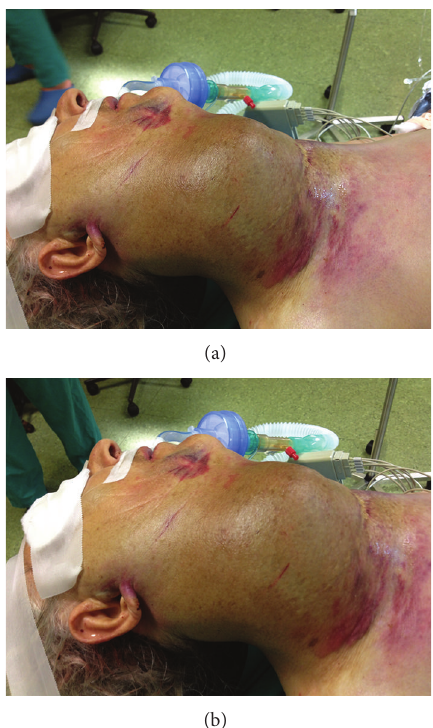
Figure 1: Patient intubated endotracheally.